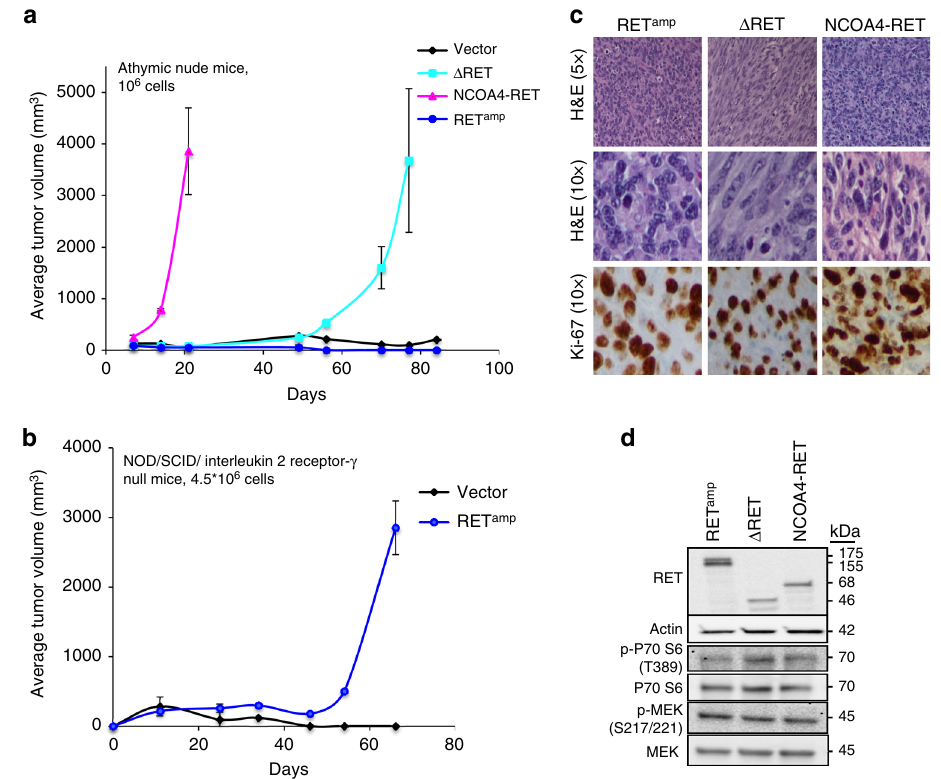
Fig. 4 Δ RET and NCOA4-RET are tumorigenic. Growth curve of tumors formed upon subcutaneous injection of transduced NIH/3T3 cells at a 1×10 6 cells, bilateral fl ank injections in athymic, nude mice ( n = 4 injection sites for vector, Δ RET, and RET amp and n = 6 injection sites for NCOA4-RET) and b >4.5×10 6 cells, bilateral fl ank injections in NOD/SCID/ interleukin 2 receptor γ null mice ( n = 4 injection sites per group) for vector and RET amp cells. Error bars represent mean ± s.d. c Representative staining for hematoxylin and eosin (H&E) demonstrates a packed population of tumor cells (top row, ×5 magni fi cation). At higher power (middle row, ×10 magni fi cation) tumor cells reveal mitoses. Tumor cells stain positive after immunohistochemistry for proliferation marker Ki-67 (bottom row, ×10 magni fi cation). d Immunoblot of tumor protein lysates from NIH/3T3 xenografts using the C-terminal RET antibody and downstream signaling